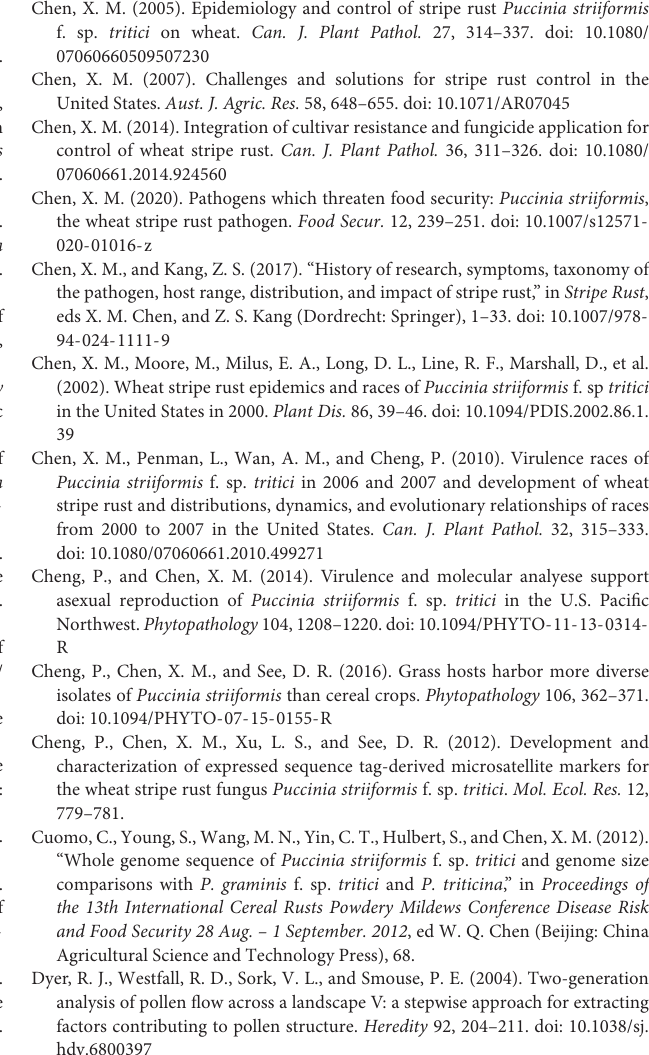
Supplementary Figure 9 | Histograms of values of rbrD calculated from 999 permutations. The observed values of rbarD are represented as vertical dashed